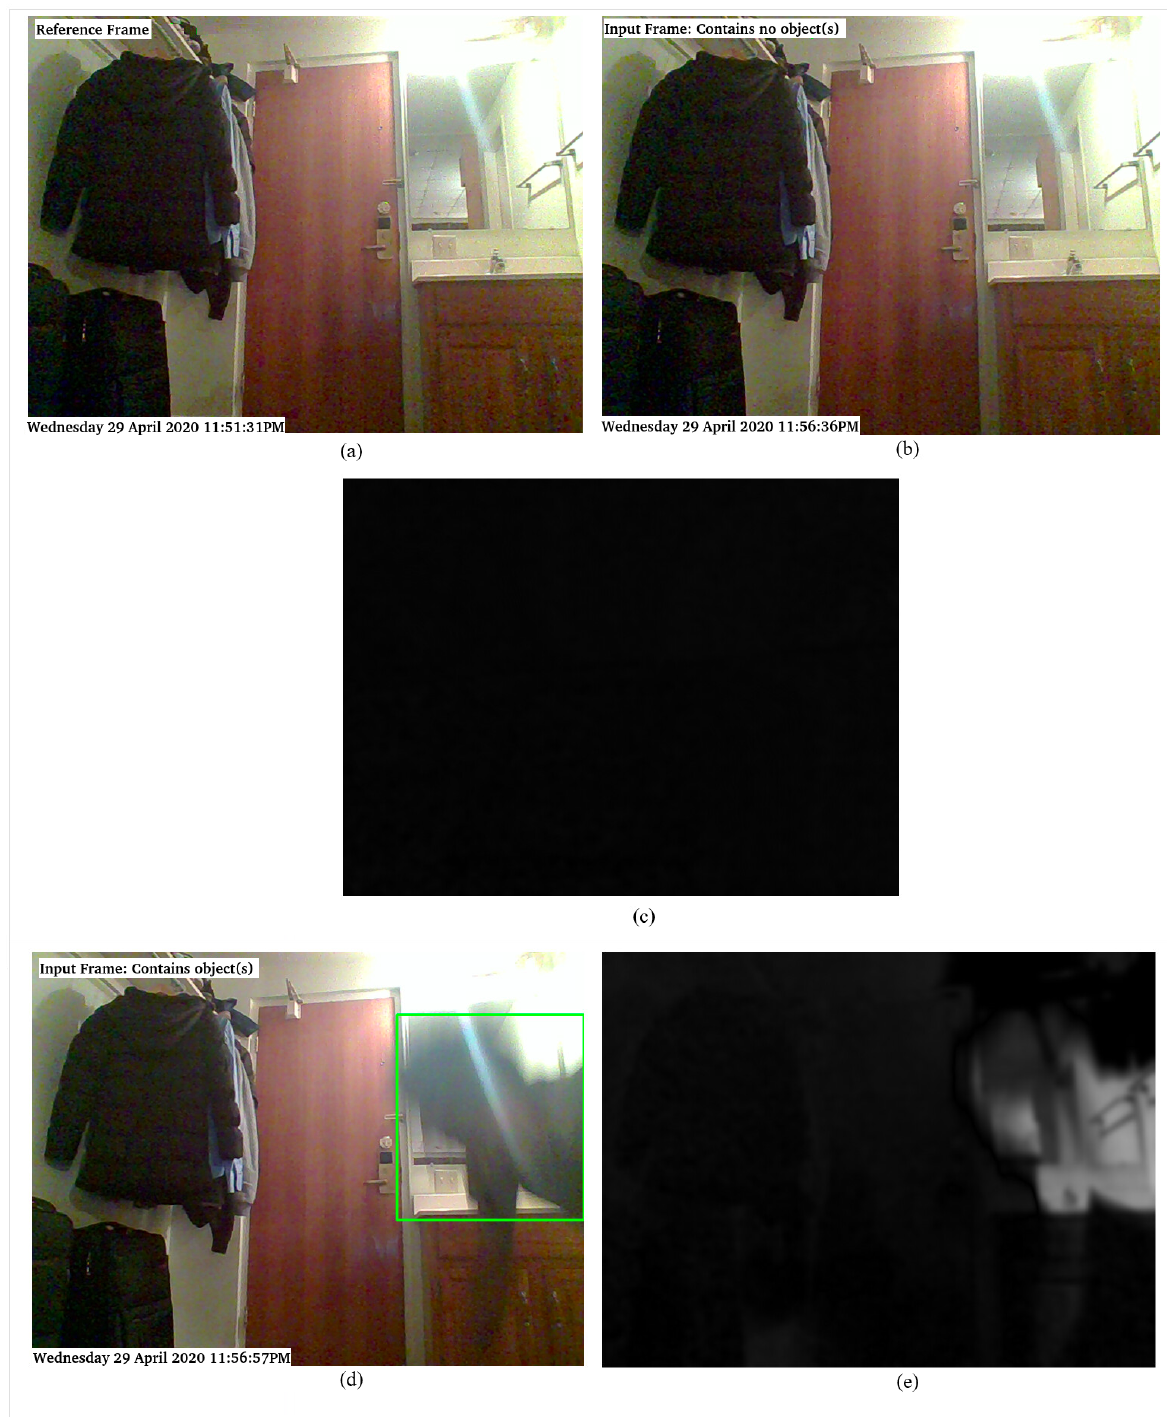
Figure 11. Raspberry PI-camera-2 Motion Detection: ( a ) reference frame, ( b ) next frame with no change, ( c ) a null frame which is the difference of ( a , b ), ( d ) frame with the shoulder and head part of a fast-moving person, and ( e ) a frame containing only the difference of ( a , d